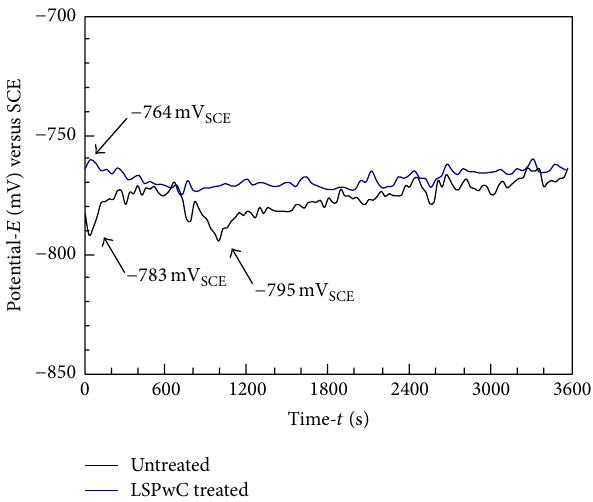
Figure 6: Micropolarisation curves of the untreated and LSPwC